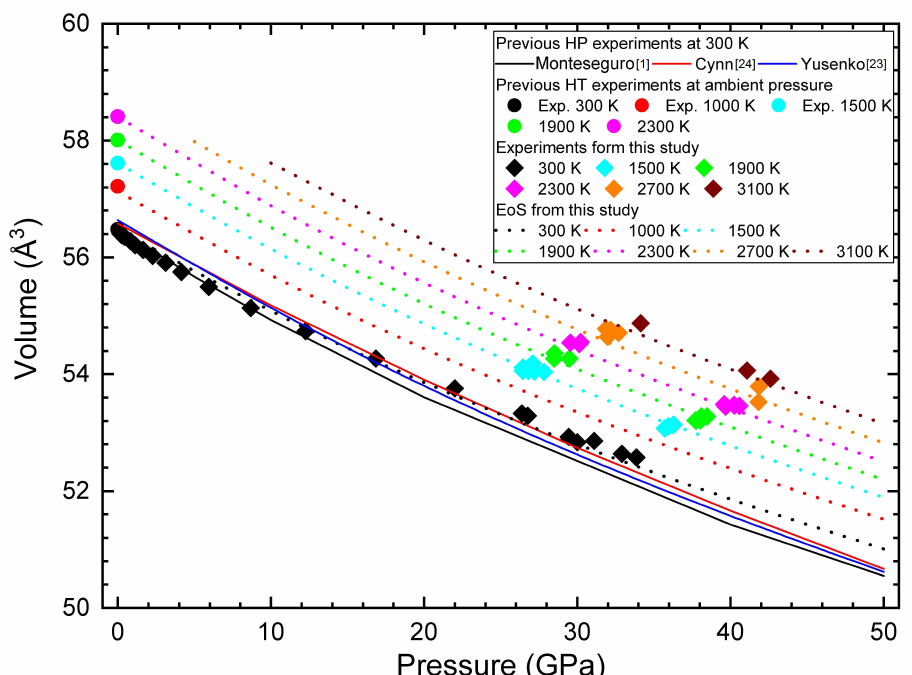
Figure 8. Unit–cell volume of Ir versus pressure for different temperatures. Diamonds correspond to the experiments of the present work. Circles are results from ambient-pressure experiments [24]. The black, blue, and red solid lines are the EoS determined from experiments carried out under He [1], Ne [22], and Ar [23]. The dashed lines are the isotherms obtained from the P – V – T EoS we